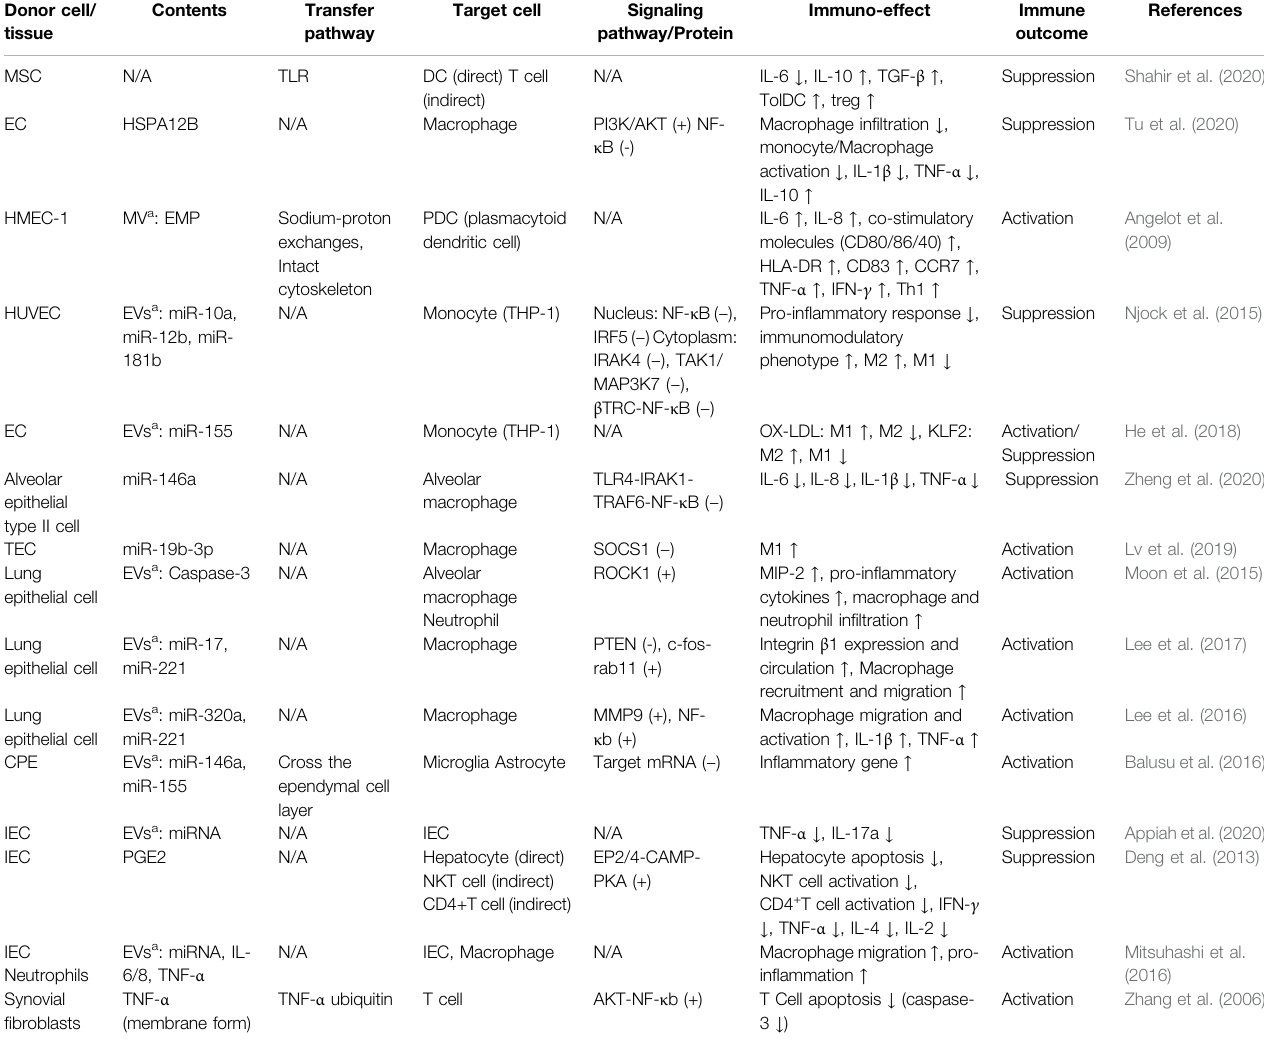
TABLE 1 | ( Continued ) Immunomodulatory effect of exosomes derived from non-immune cells in